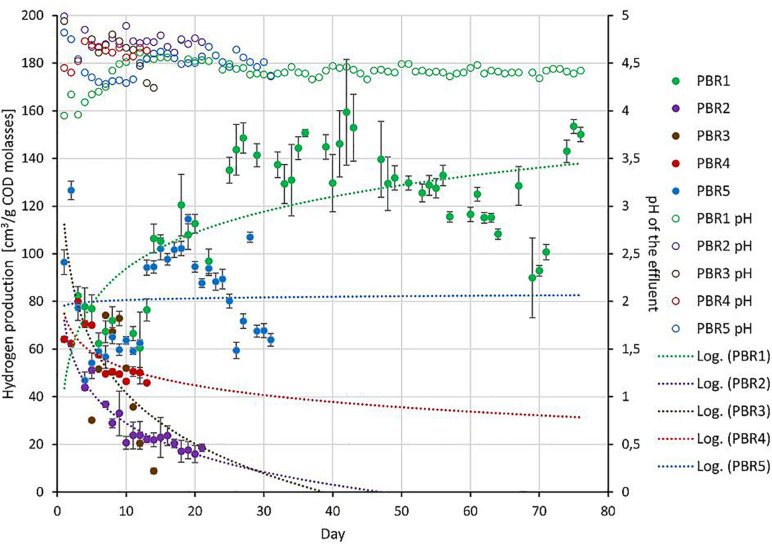
The long-term performance of PBRs tested in this study: hydrogen production (solid circles, left axis) and pH of the effluents (open circles, right axis) from bioreactors. Since the operation periods were different, trend lines were added for hydrogen-production data sets.